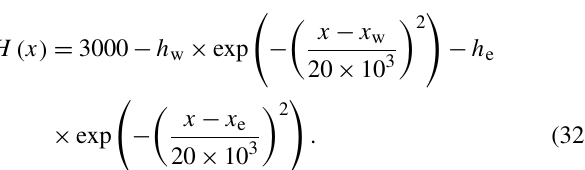
approximately with the Gaussian function given